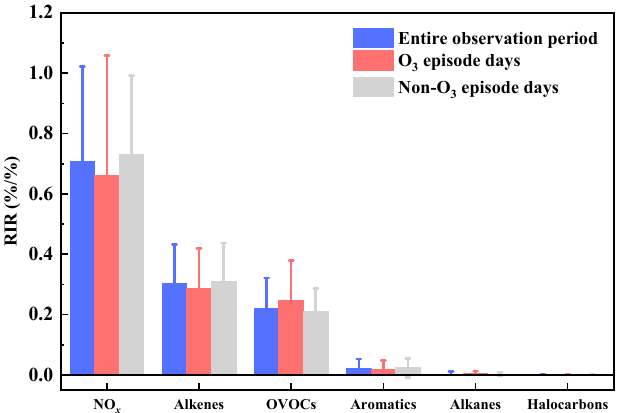
Figure 6. The RIR values of O 3 precursors in different pollution periods during the observation daytime (06:00–18:00).